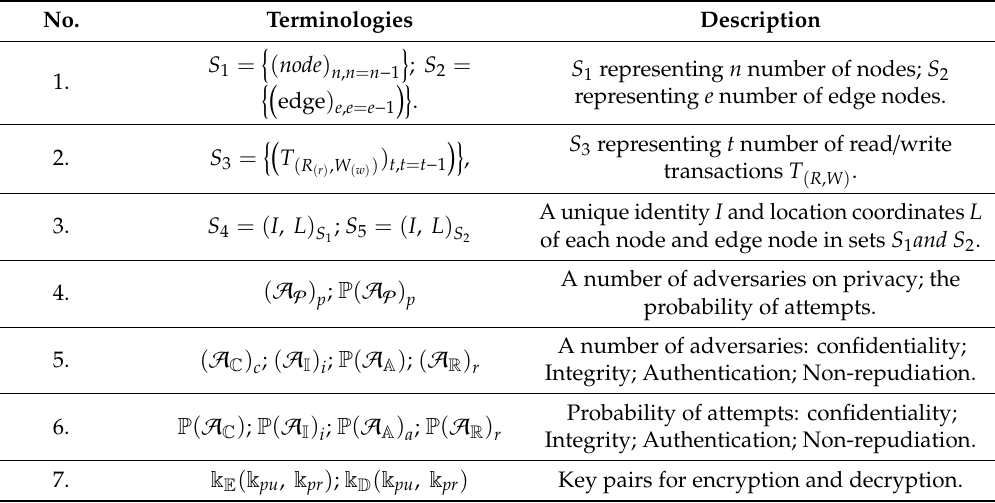
Figure 2. Privacy processing: numbers of steps are used to process the privacy statement, considering communication case 1: nodes to 𝐶𝑆 communication; therefore, in similar manners, we can process the privacy statement for case 2, case 3, and case 4. Table 1. System terminologies.